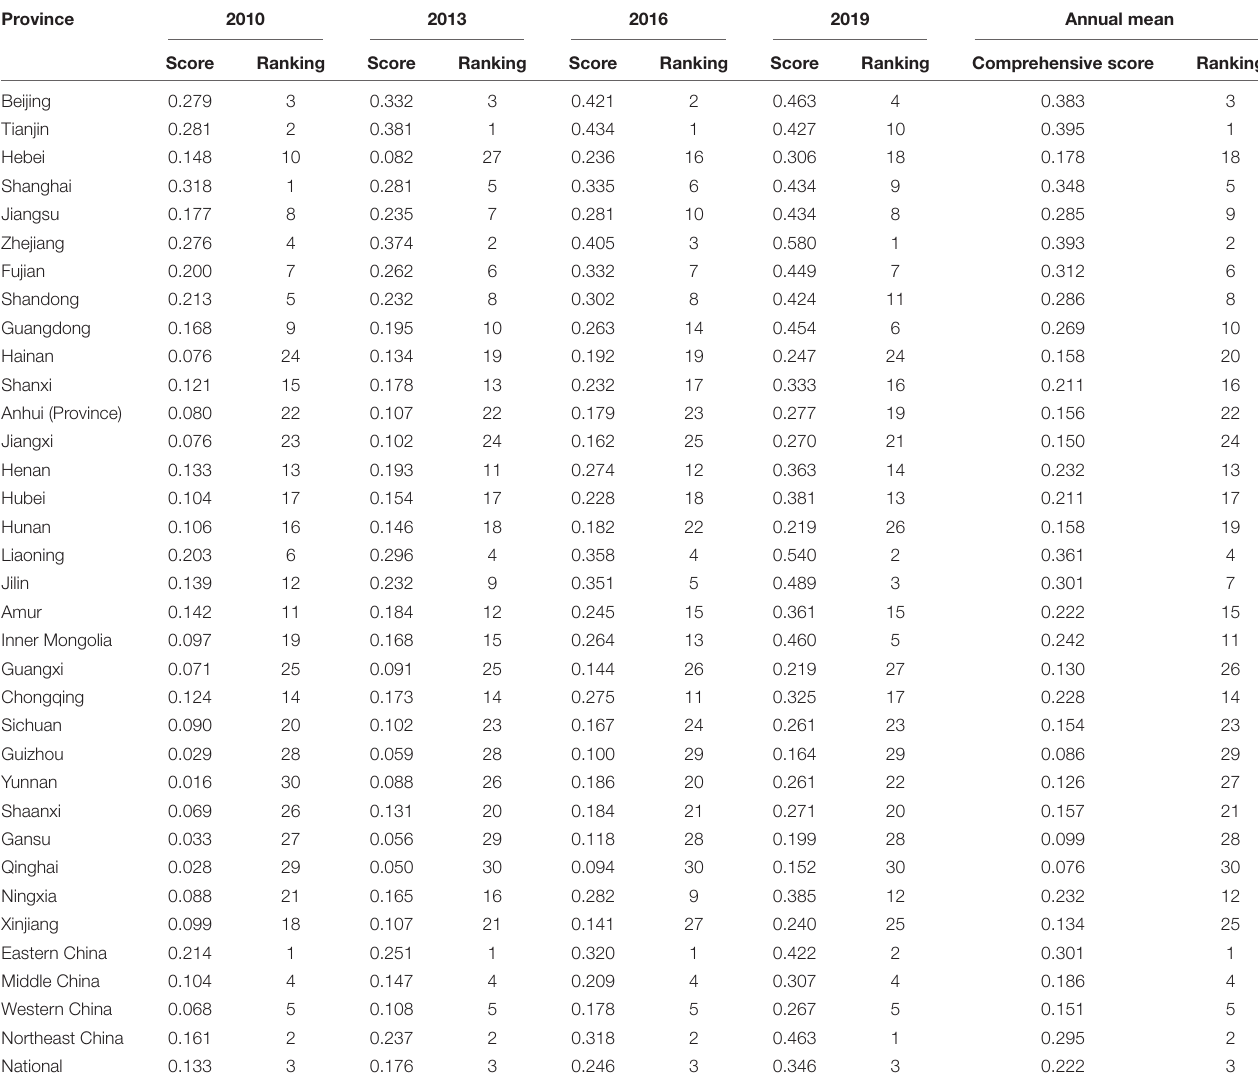
TABLE 2 | System quality measurement in some years in China from 2010 to 2019.